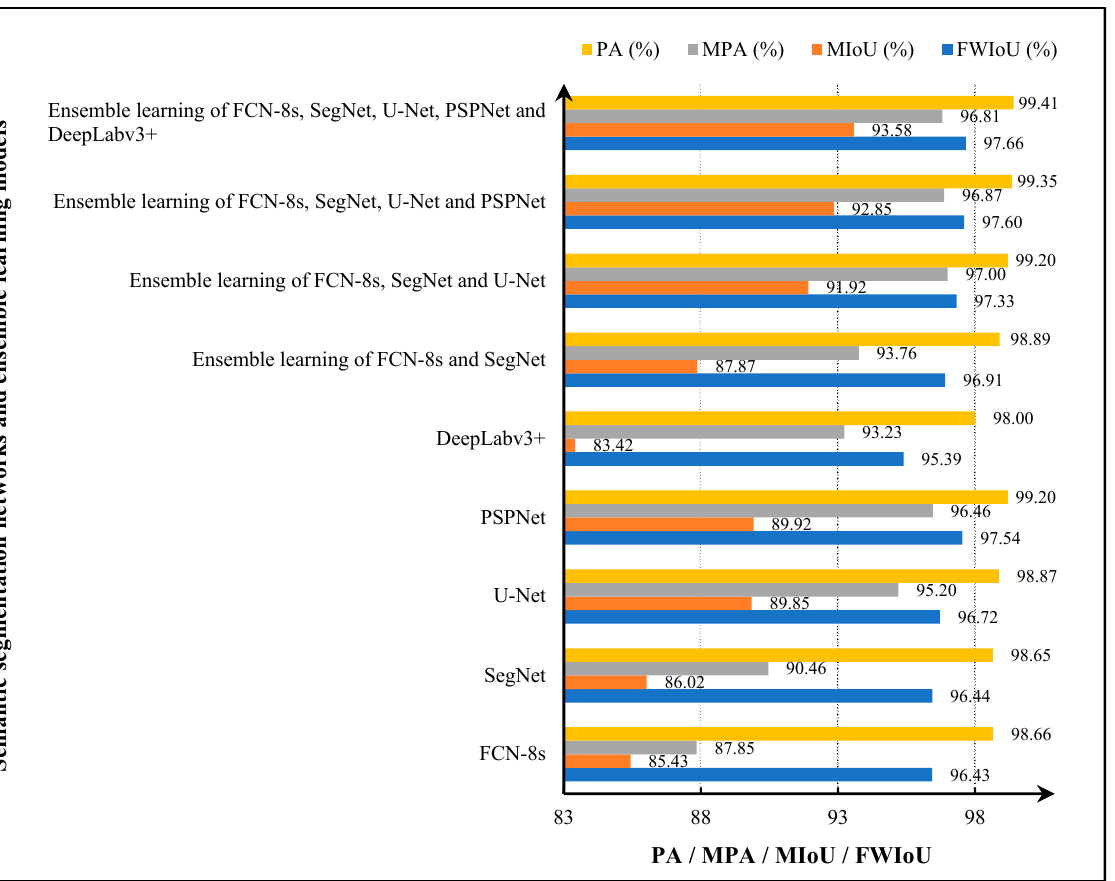
Figure 10. Performance comparison of five semantic segmentation networks and four ensemble learning models.